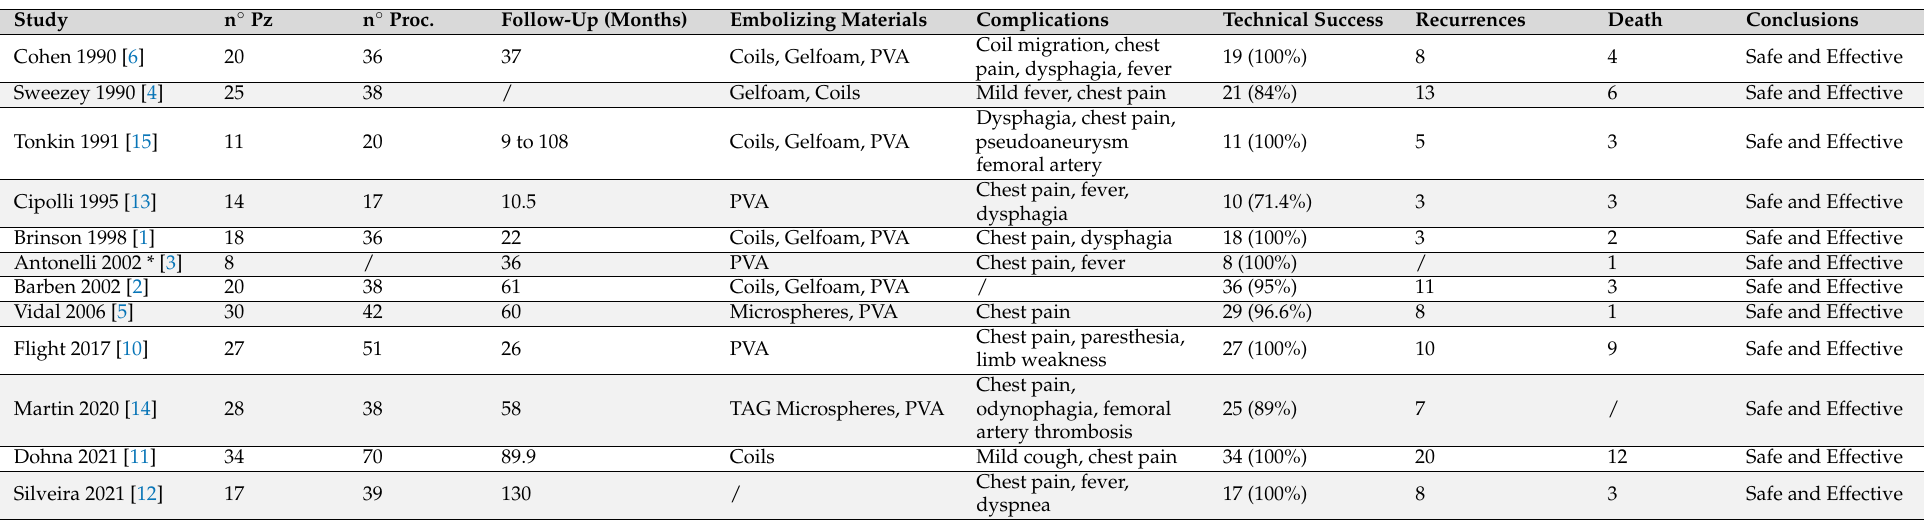
Table 3. Main characteristics of previous studies which are present in the